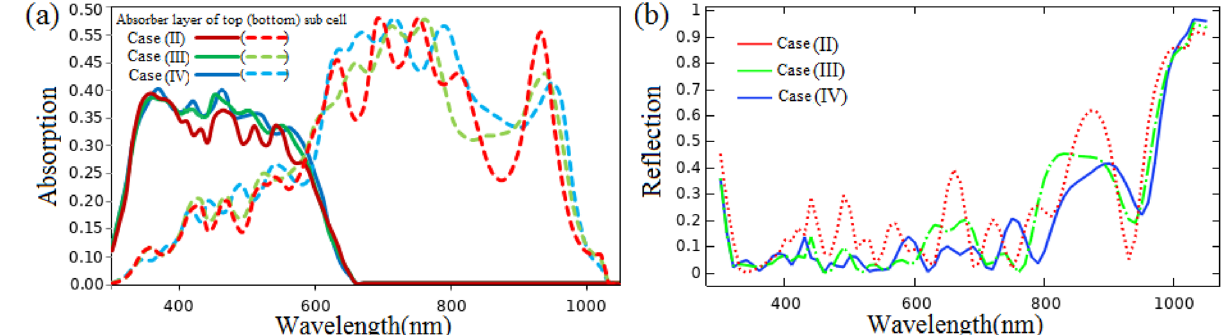
Figure 8. Absorption spectrum of absorber layer of the top and bottom sub cells ( a ) and total reflection spectrum ( b ) for cases (II)–(III).